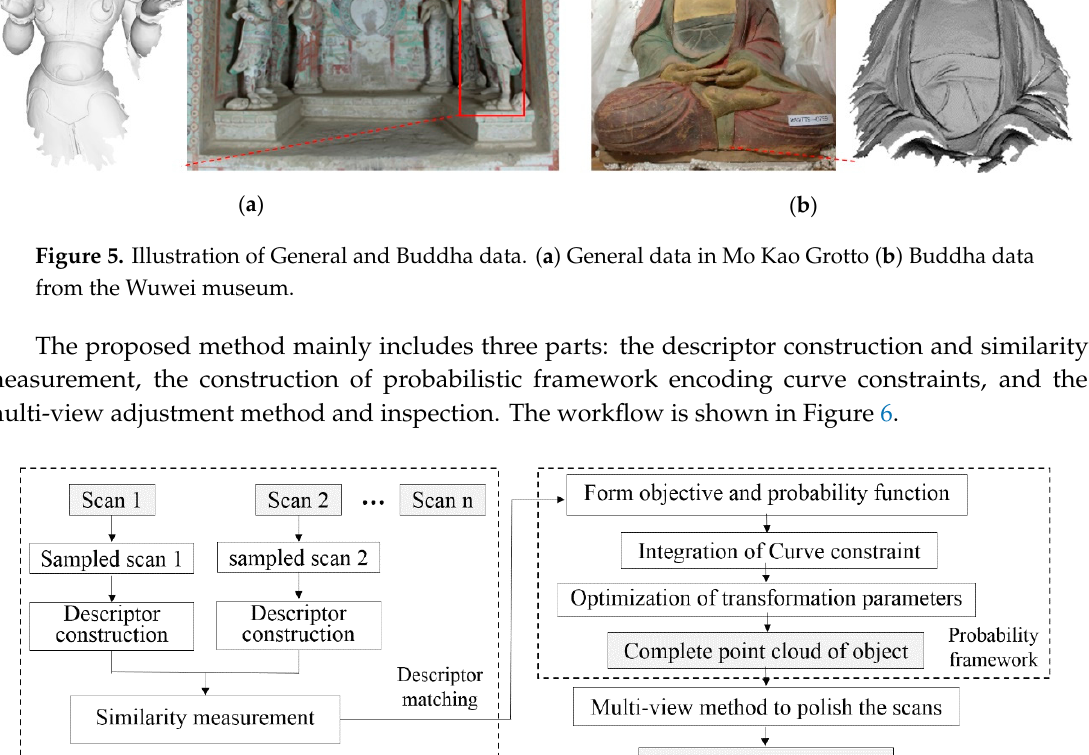
Figure 4. Design of the target net and fixed support.